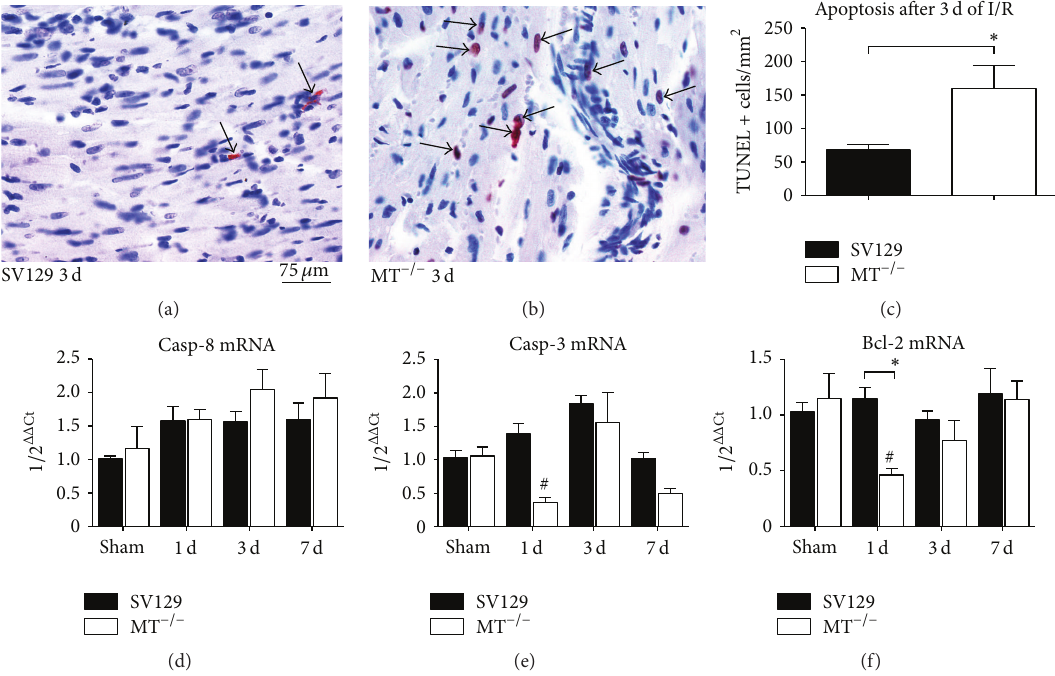
Figure2:IncreasedcardiomyocyteapoptosisinMT −/− -hearts.RepresentativeslidesofTUNELstainedsectionspresent(a)onlyfewapoptotic nuclei in cardiomyocytes of WT-hearts, when compared to (b) numerous nuclei with DNA-fragmentation in MT −/− -hearts after 3 days of (d) I / R. (c) TUNEL-positive cells after 3 days of I / R. RT-qPCR showing mRNA expression of (d) caspase- (Casp-) 8, (e) caspase- (Casp-) 3, and (f) B-cell lymphoma (Bcl)-2 during repetitive I / R. 𝑛 = 8–10/group; scale bar in (a) and (b): 75 𝜇 m; RT-qPCR using Taqman, mRNA expression is related to shams and GAPDH using comparative ΔΔ Ct-method; ∗ indicates P ≤ 0.05 between the genotypes; # indicates P ≤ 0.05 versus respective